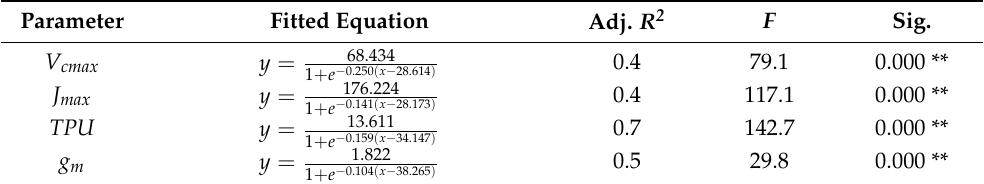
Table 6. Curve-fitting of photosynthetic biochemical parameters of spring wheat leaves under rapid-drought indicate levels of significance at p < 0.05 and p < 0.01, respectively.